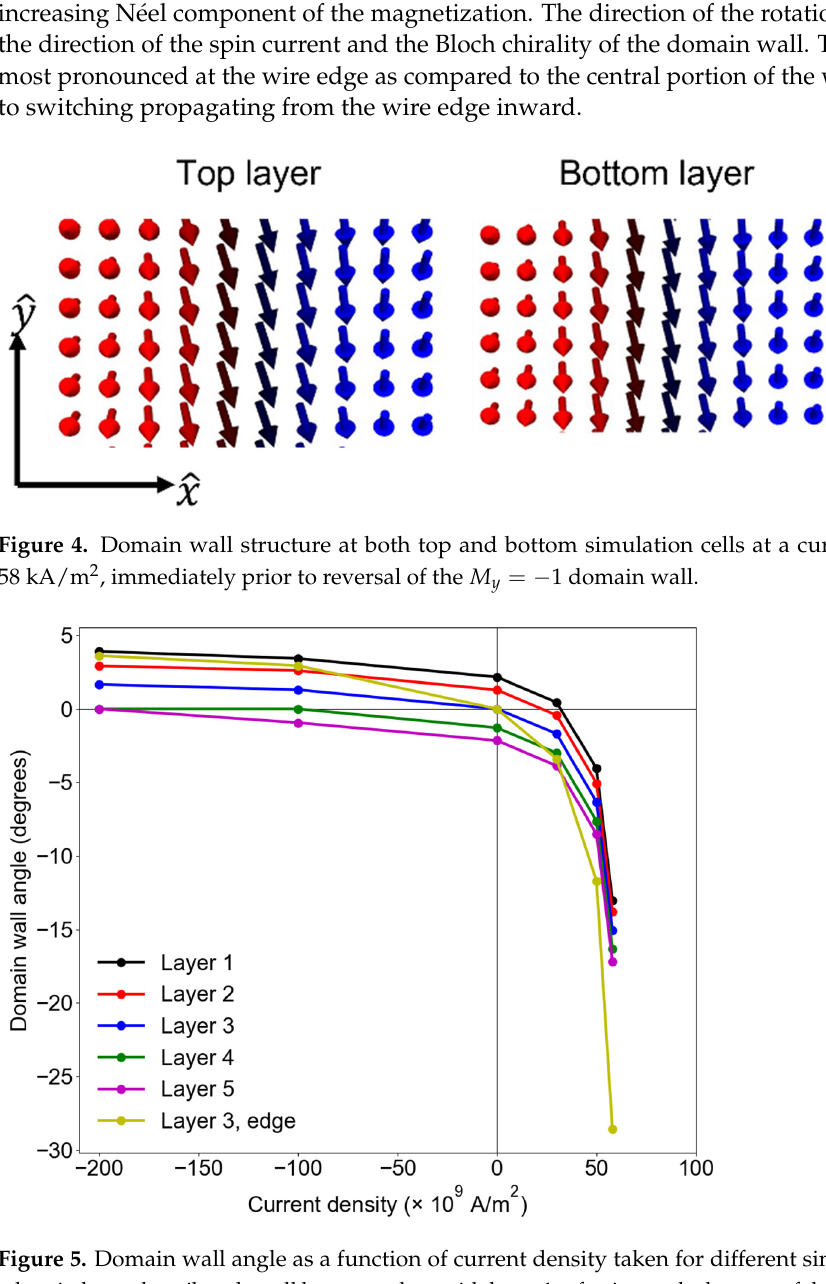
Figure 5. Domain wall angle as a function of current density taken for different simulation layers, wherein layer describes the cell layer number, with layer 1 referring to the bottom of the wire geometry, and 5 corresponding to the top of the wire geometry. Unless otherwise noted, the domain wall angle is determined by the maximum rotation away from a purely Bloch domain wall, with a positive value denoting a clockwise rotation, and counterclockwise negative, along the center of the wire. Data for the domain wall angle at the edge of the wire are also shown. Results are shown for M Y = −1 .